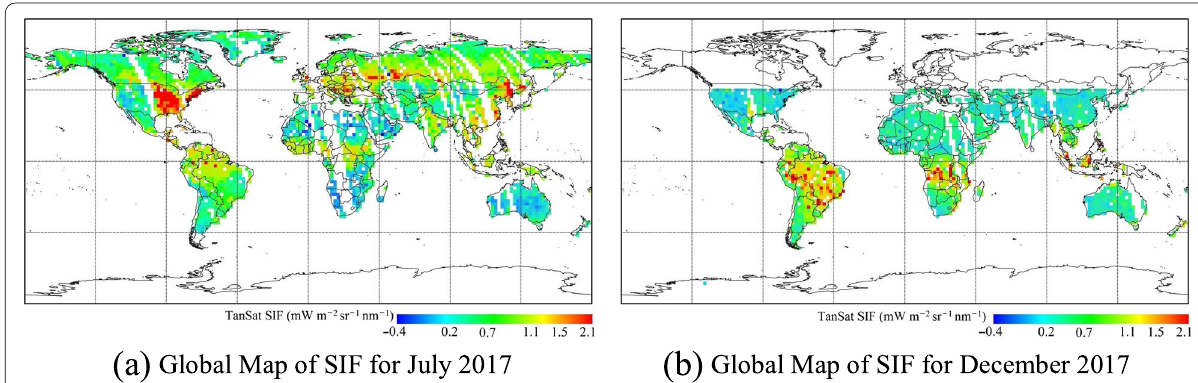
Fig. 9 Global maps of SIF by Tansat. a Global Map of SIF for July 2017. b Global Map of SIF for December 2017